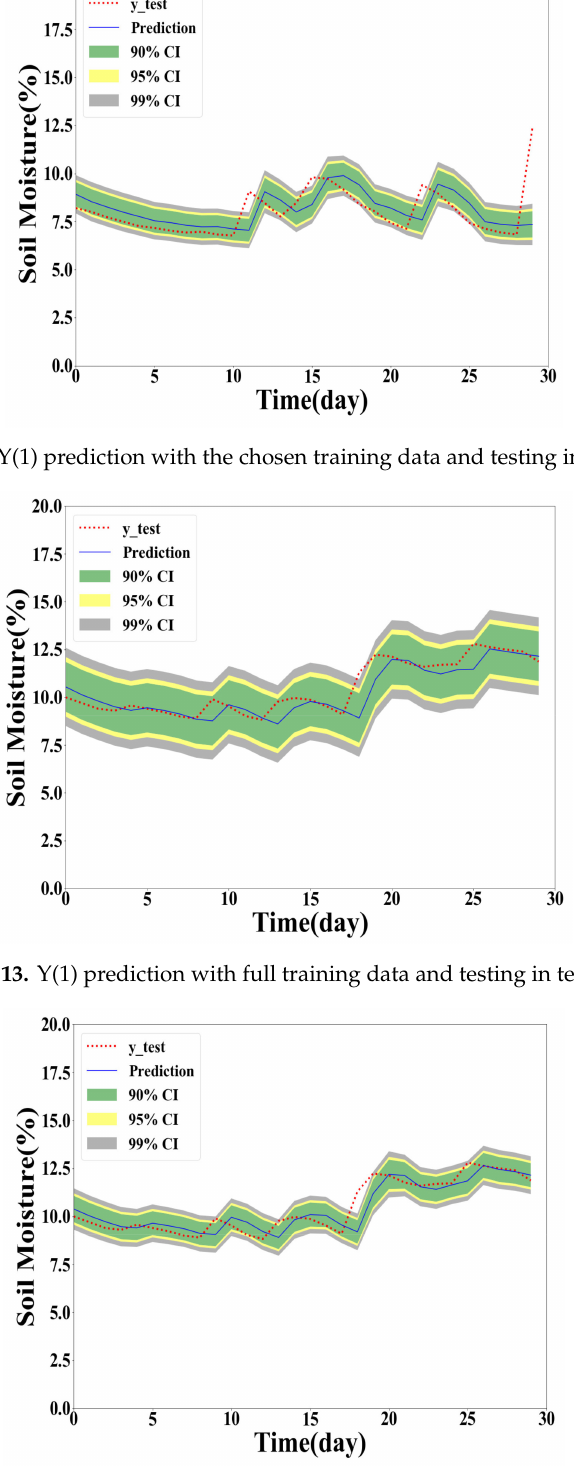
Figure 14. Y(1) prediction with the chosen training data and testing in test